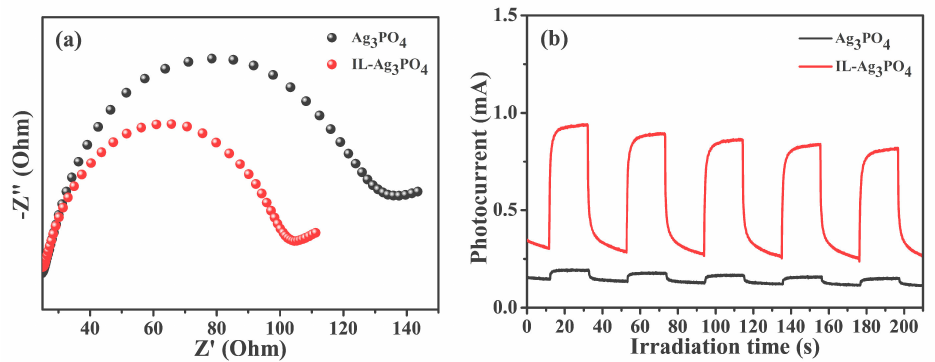
Figure 7. ( a ) Electrochemical impedance spectra and ( b ) transient photocurrent response of Ag 3 PO 4 and IL-Ag 3 PO 4